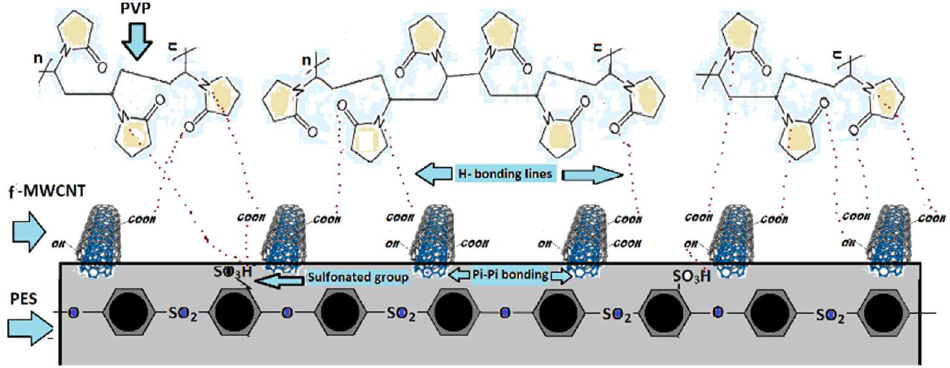
Figure 1. Schematic representation of SPES and NCs (f-MWCNT/PVP) arrangement in fabricated membranes.